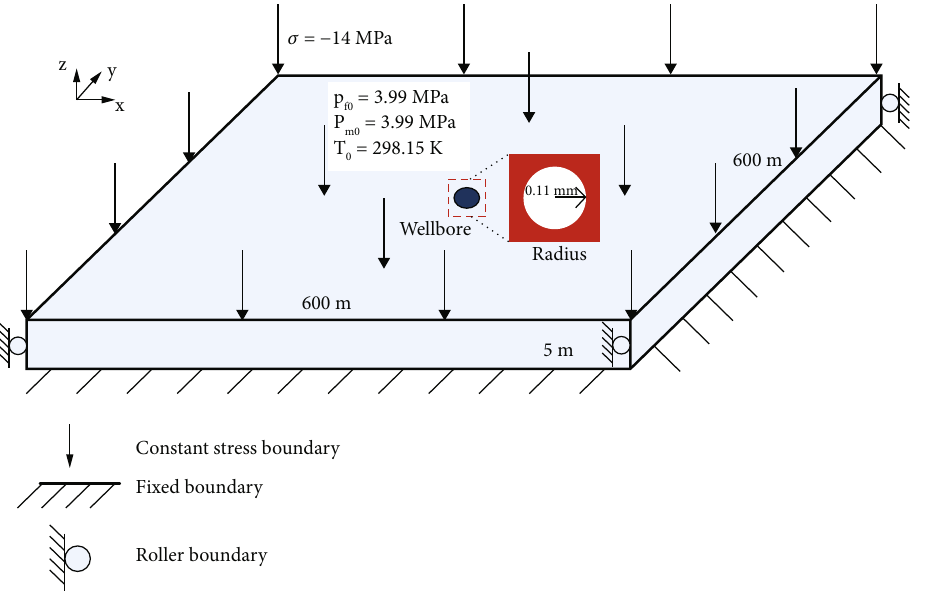
Figure 6: The site situation, initial state, and boundary conditions of the gas fi eld utilized for validation. Table 2: The key parameters used for the simulation in Section 3 are listed as follows. Parameter Value Unit Parameter Value Unit Density of coal 1650 kg m -3 Young ’ s modulus 3 GPa Poisson ’ s ratio 0.3 — Initial porosity of fracture 0.0302 — Permeability of coal 1 : 63 × 10 − 13 m 2 Langmuir strain constant 0.03 — Langmuir pressure constant Pa Langmuir volume constant 0.045